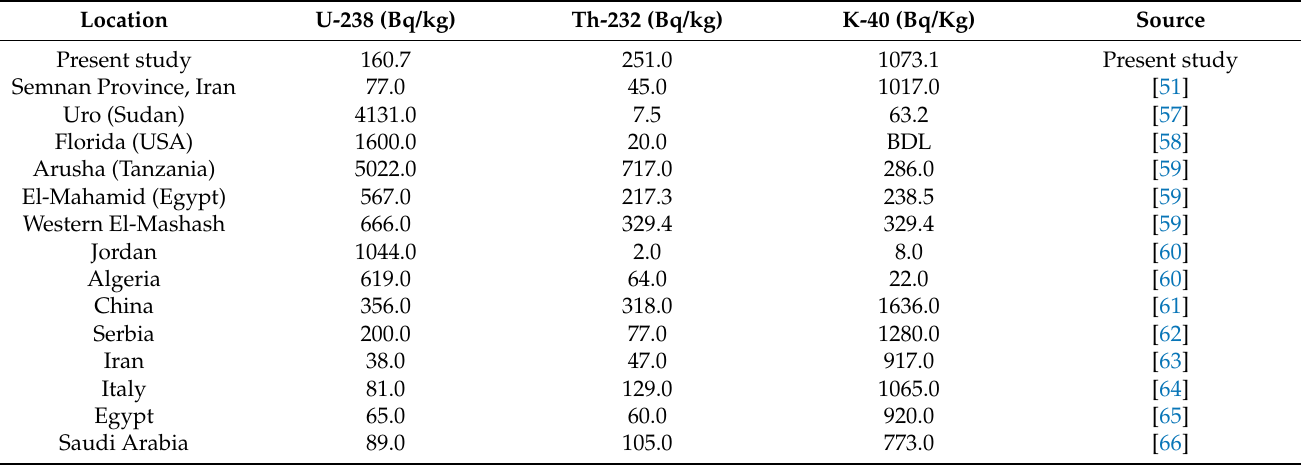
Table 2. Comparison of mean activity concentrations in the present study with other results available in literature